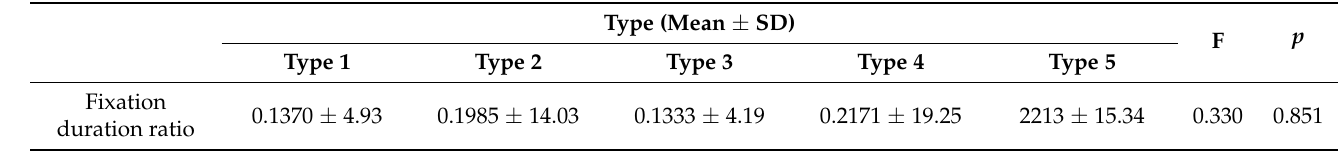
Table 28. Analysis of variance for the proportion of fixation time on buttons of different sizes.